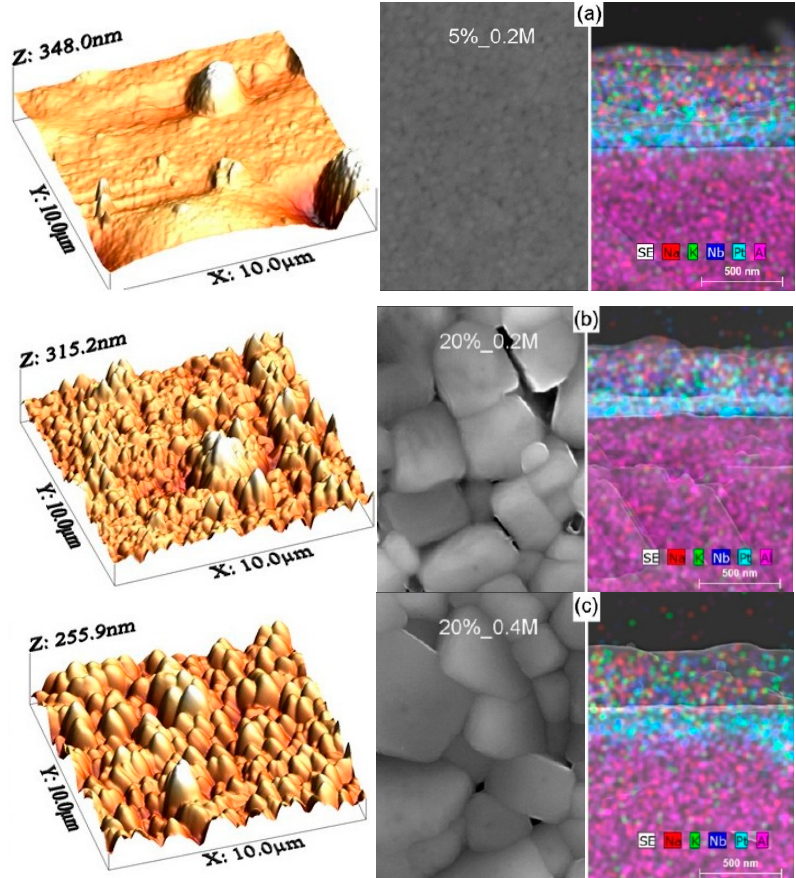
Figure 1. AFM (left), SEM top-view (centre) and SEM cross-section (with elemental map) micrographs (right) of KNN thin films deposited on platinized Al 2 O 3 substrates from solutions with 5% potassium excess and 0.2 M concentration ( a ), 20% alkali excess and 0.2 M concentration ( b ) and 20% alkali excess and 0.4 M concentration ( c ). Note that the scale bar is the same for both top and cross-section views.